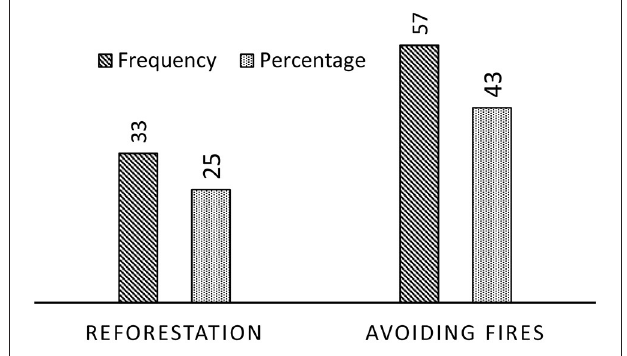
FIGURE 4 | Prominent mitigation strategies (multiple response) n = 58, Source: primary